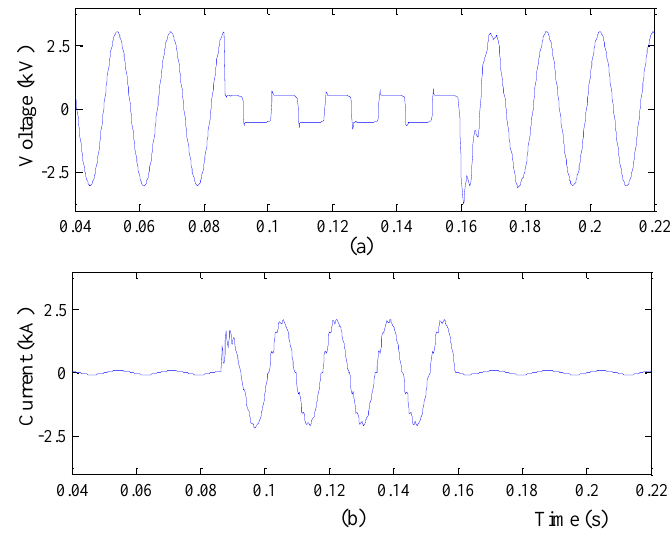
Figure 2. Multi-cycle incipient fault (IF) event at fault location: ( a ) voltage; ( b ) current. Table 3. Incipient fault (IF) Model